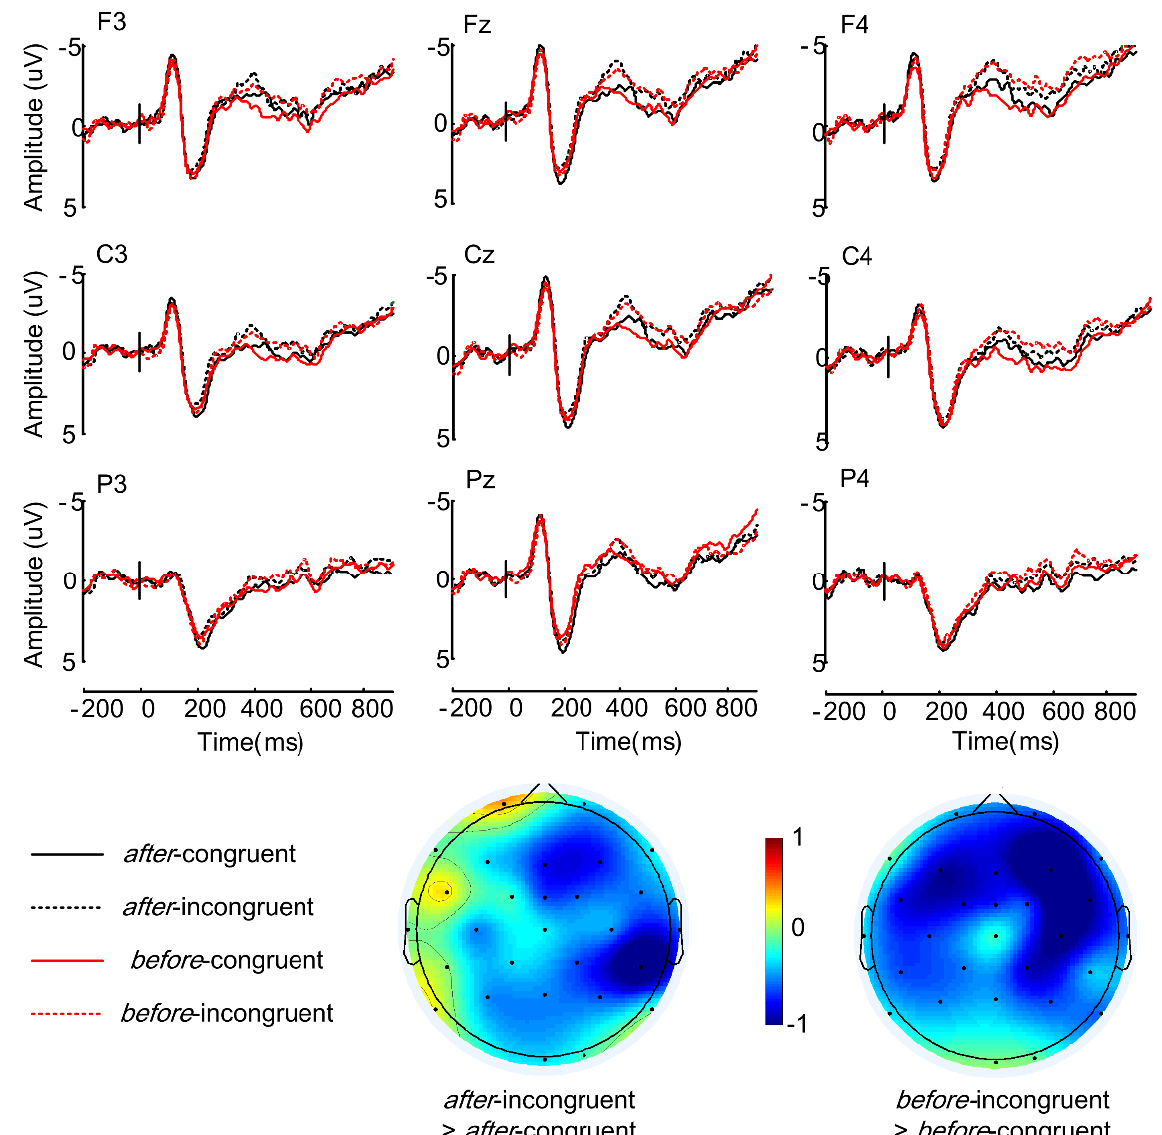
Figure 2. ERP responses to sentence-final words in each of the four conditions at 9 representative electrodes are shown in the graph. Scalp distributions of the relevant difference effects (in the 300–800 ms time window) are given below the ERP graph.